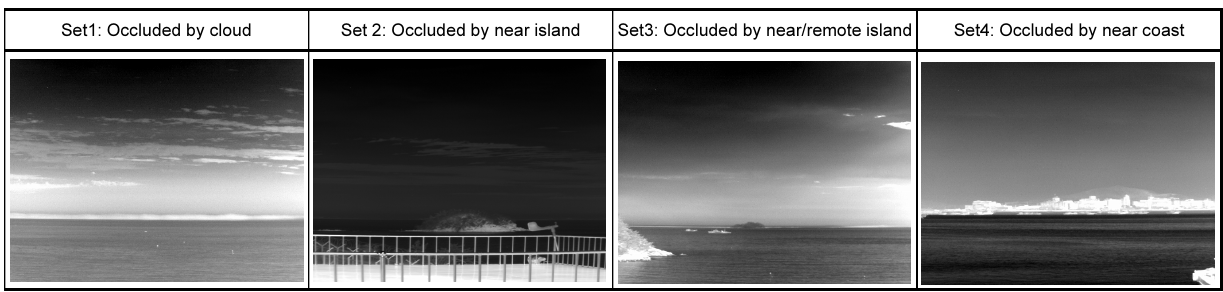
Figure 22. Composition of the test database for horizontal line